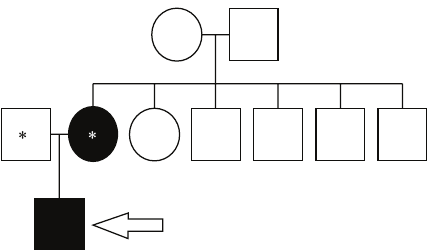
Figure 1: Pedigree showing the affected mother (white asterisk), unaffected partner (black asterisk), and affected infant (white arrow).